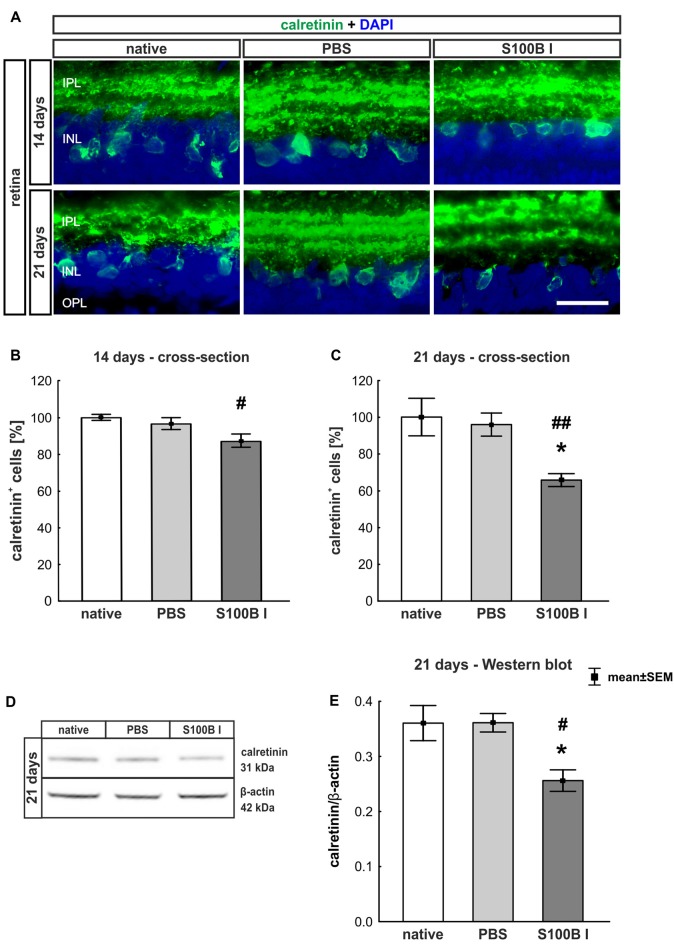
Progressive loss of amacrine cells after intraocular S100B injection. (A) We performed immunohistochemical evaluations of amacrine cells (calretinin, green) 14 and 21 days after S100B injection. Cell nuclei were stained with DAPI (blue). (B) The examination of calretinin+ cells at 14 days revealed a trend to a loss of cell bodies compared to the PBS (p = 0.084) and a lower cell number compared to the native group (p = 0.015). (C) Whereas, the evaluation after 21 days already showed significantly fewer amacrine cells in the S100B I group compared to the both controls (PBS: p = 0.014, native: p = 0.0098). (D) The protein level of calretinin (31 kDa) was measured with Western blot at day 21 and normalized with β-actin (42 kDa). (E) The calretinin protein level decreased at day 21 in comparison to both controls (both: p = 0.025). IPL, inner plexiform layer; INL, inner nuclear layer; scale bar = 20 μm, *p < 0.05 (compared to PBS group); #p < 0.05, ##p < 0.01 (compared to native group).